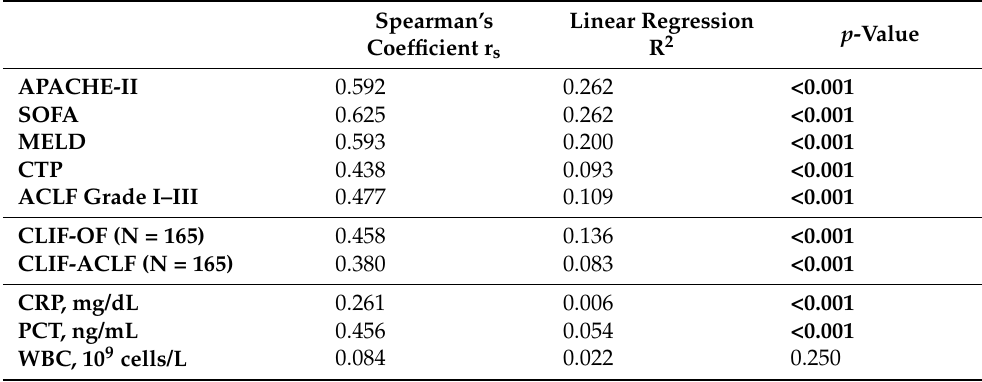
Table 2. Correlations and linear regressions of baseline EASIX with conventional clinical scores and laboratory parameters on admission to the ICU.